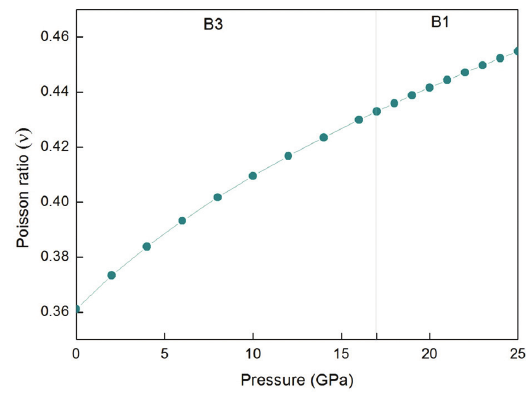
Figure 6. Poisson ratio behavior under pressure for GaAs.